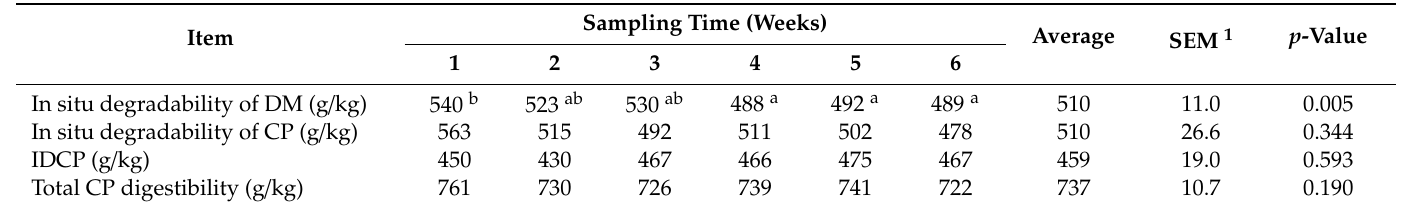
Table 4. In situ rumen degradability of dry matter (DM) and crude protein (CP) after 16 h of incubation, in vitro intestinal digestibility of CP (IDCP), and total CP digestibility of tomato pomace samples taken from two processing plants at weekly intervals during the tomato harvesting campaign. Sampling Time (Weeks) Average SEM 1 p -Value Item